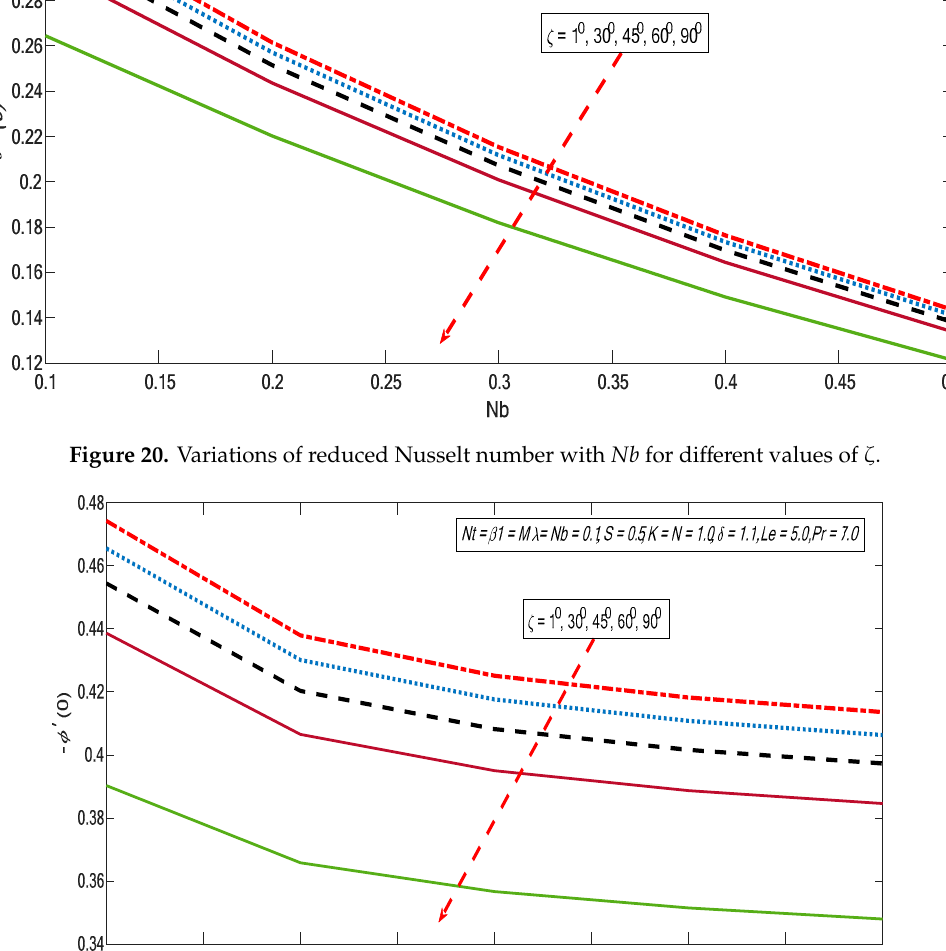
Figure 21. Variations of reduced Sherwood number with 𝑁𝑏 for different values of 𝜁 .